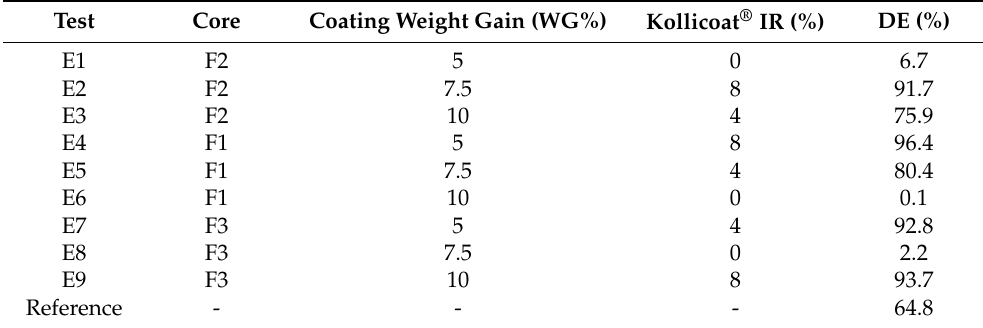
Figure 2. Dissolution profiles of the coated mini-tablet and reference product (Selopress Zok ® ) formulations, as evaluated in the following conditions: 900 mL of pH 6.8 phosphate buffer, paddle + sinker, and a 100 rpm rotation speed. Table 5. Results of dissolution efficiency (DE%) obtained for MS from the coated mini-tablets and the reference drug product (Selopress Zok ®